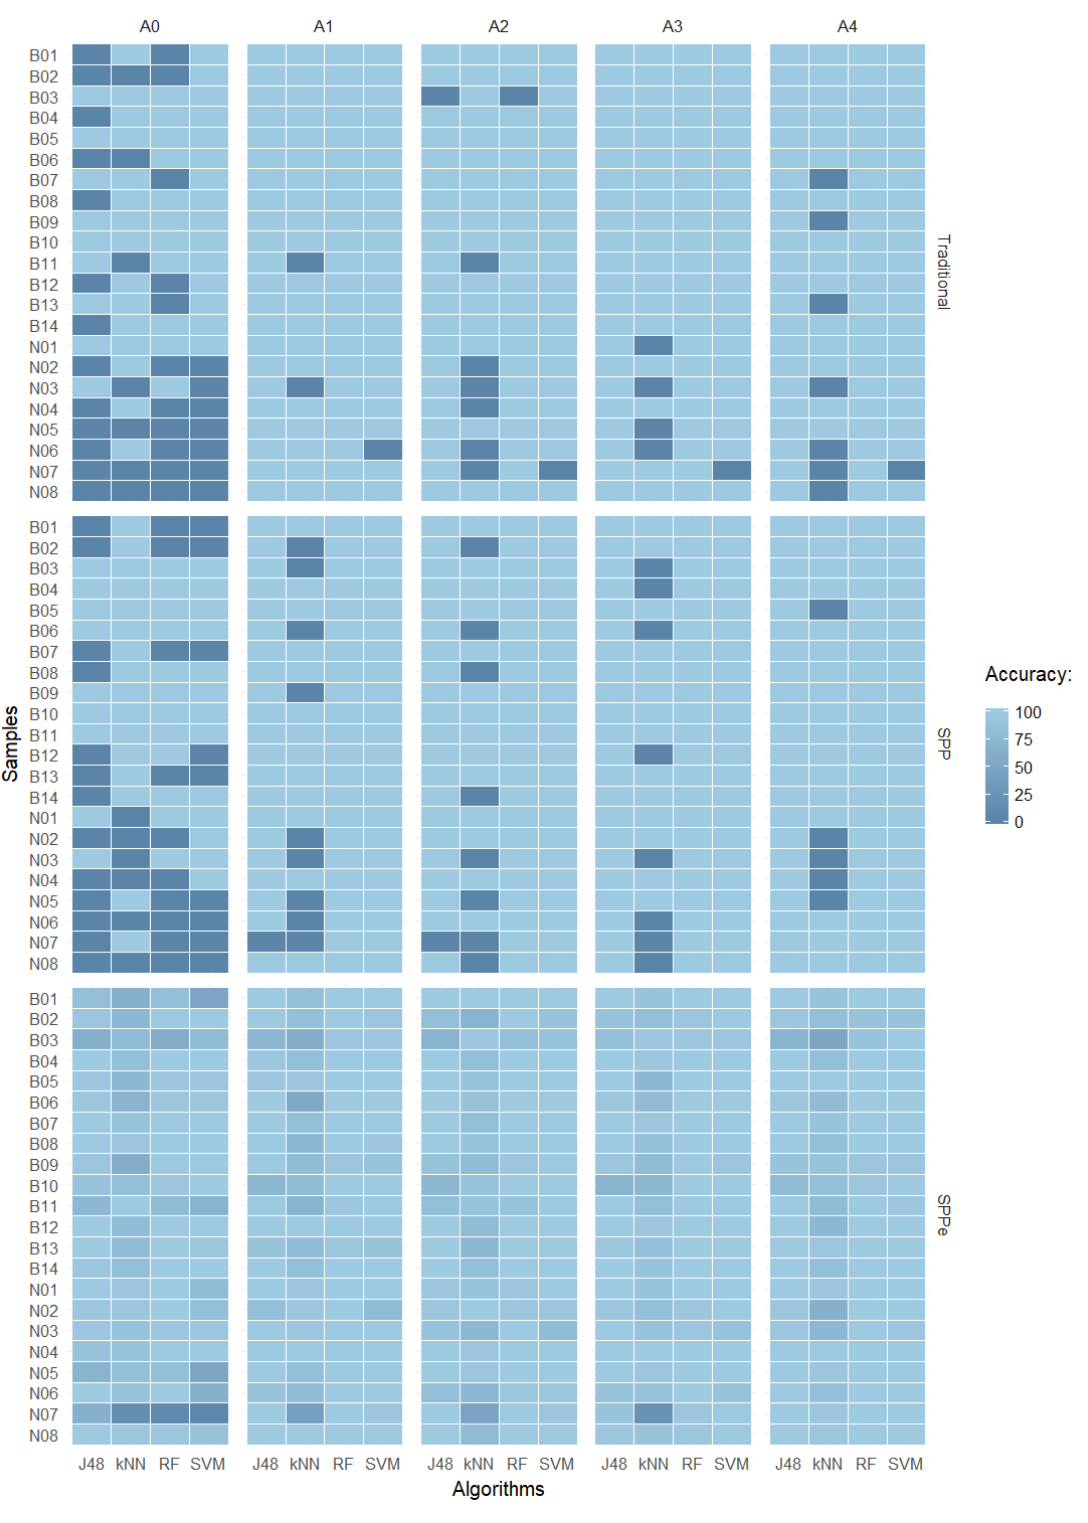
Figure 6. Accuracy heat map of J48, k-NN, RF, and SVM over the prediction dataset comparing traditional CVS, SPP, and SPPe techniques with repetitions A0, A1, A2, A3, and